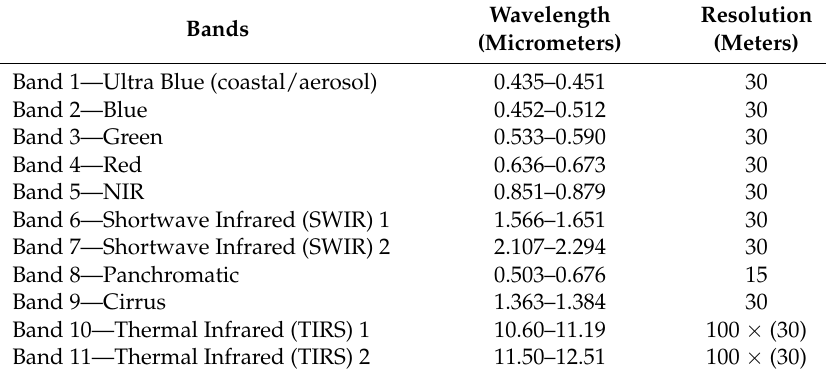
Table 2. Landsat 8 spectral bands, wavelengths and spatial resolution.